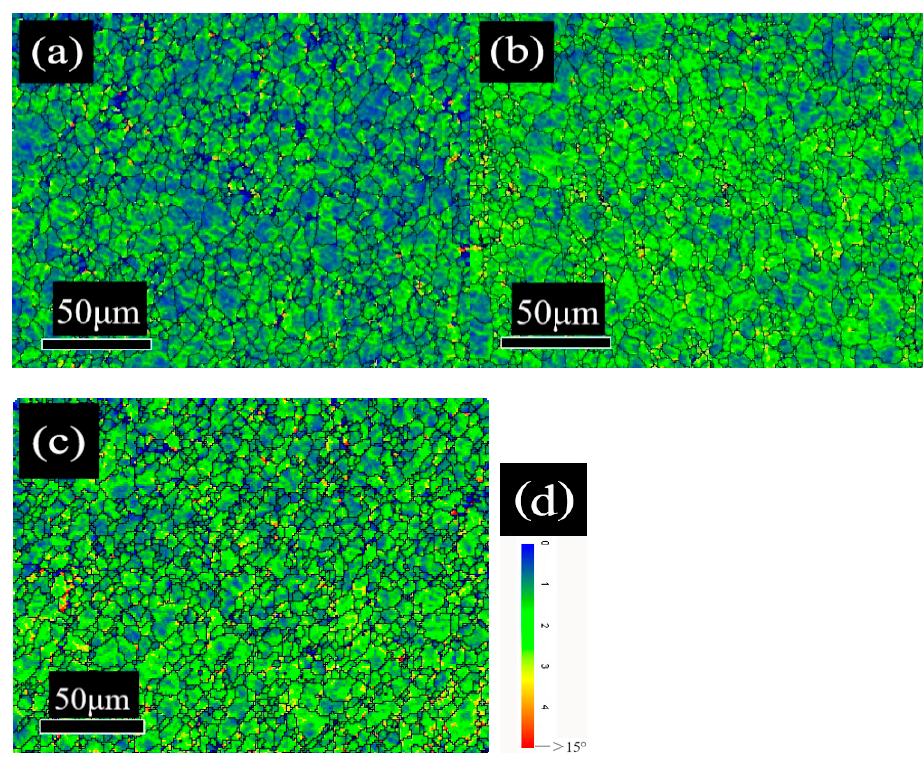
Figure 6. Local misorientation distribution with different secondary cold reduction rates: ( a ) 15%; ( b ) 20%; ( c ) 25%; ( d ) color legend.